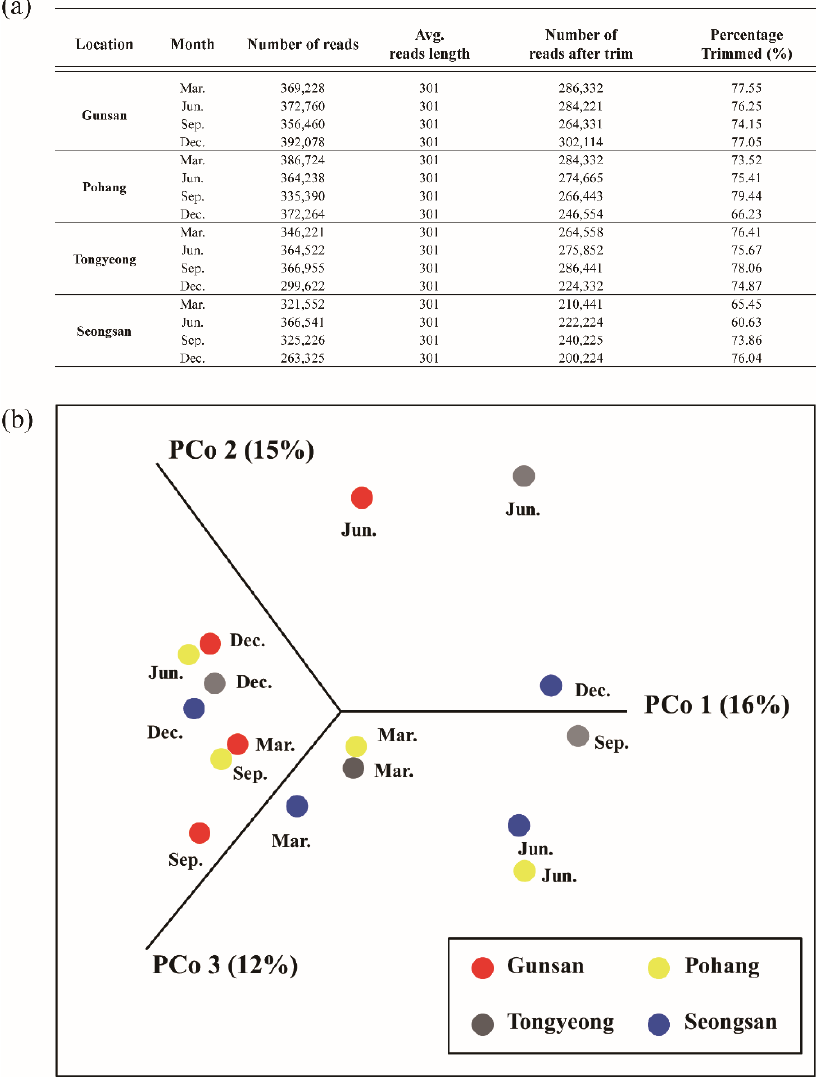
Figure 2. Comparison of metagenome libraries. Next-generation sequencing metadata including number of reads and trimmed reads ( a ), β -diversity (principal coordinate analysis (PCoA), dinoflagellate genotype composition (proportions) was measured by Bray–Curtis distances ( b ).